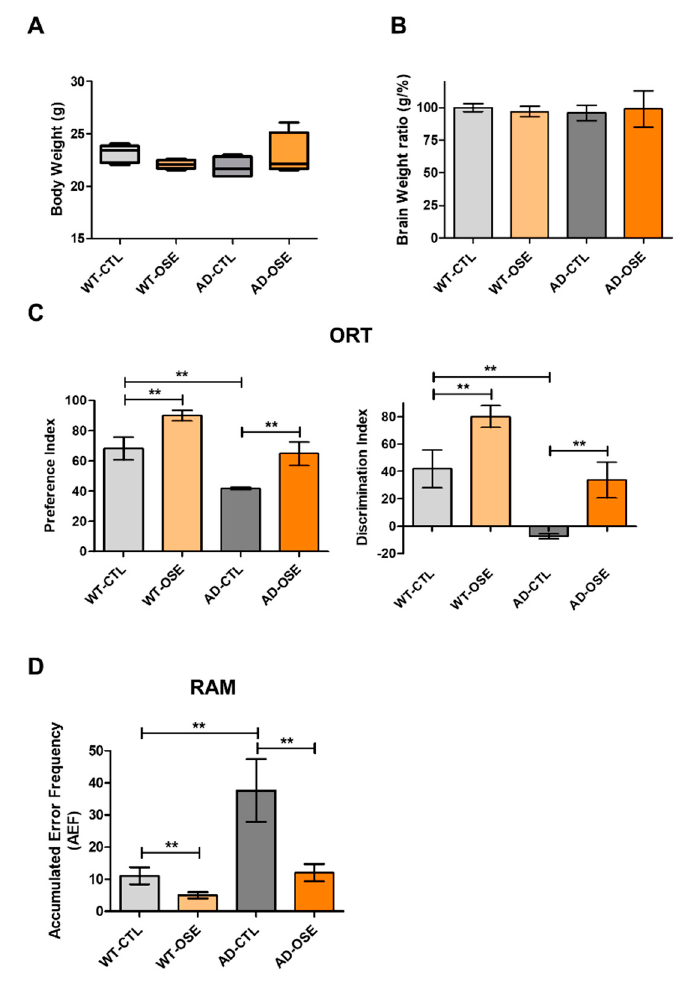
Figure 6. OSE attenuating memory impairment. ( A,B ) The body and brain tissues of mice were weighed at the last experiment (six weeks). ( C ) Novel object recognition task in Tg-5xFAD AD mice and their control group (non-Tg mice). The discrimination index was calculated as the percentage ratio of TB /( TA + TB ) × 100. TA : familiar object. TB : novel object. ( D ) Radial arm maze test assessed spatial memory. Change denotes the percentage of non-overlapped frequency entries compared with the overall entries within three arms. ** p < 0.01.